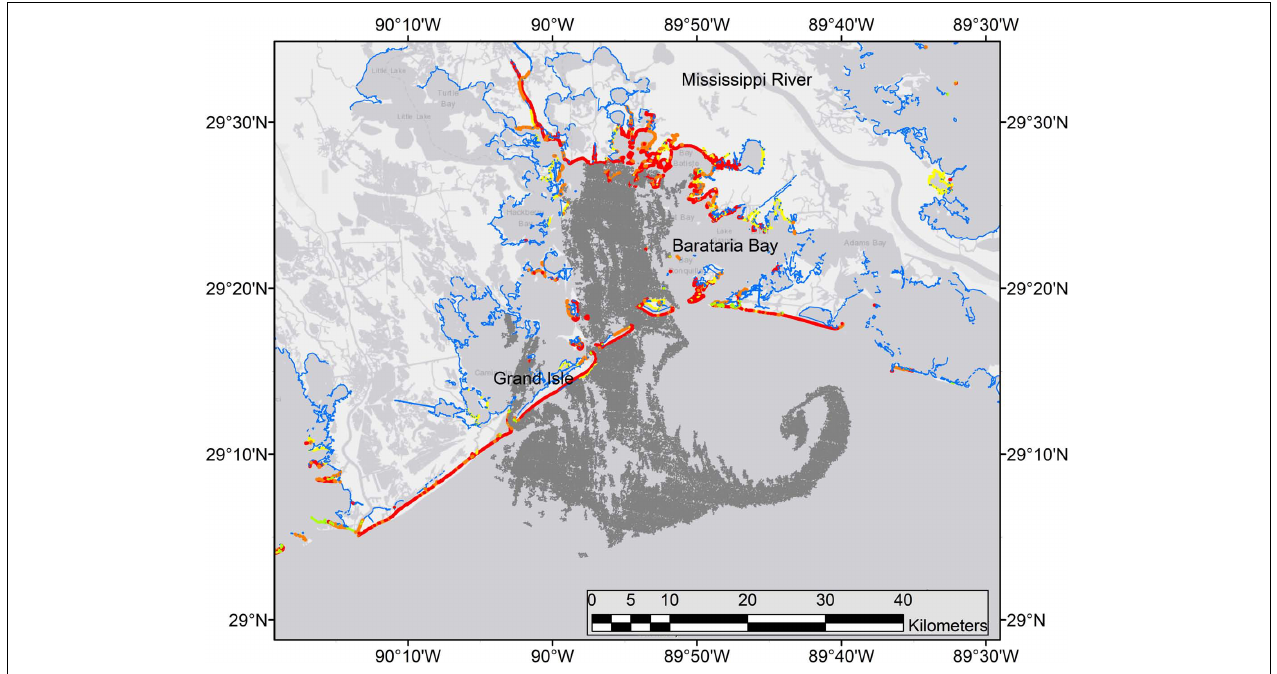
FIGURE 11 | Synthetic aperature radar (SAR) image of oil at the sea surface (dark gray) across the mouth of Barataria Bay, Louisiana, June 4, 2010. Details of instruments and processing methods are given here: https://erma.noaa.gov/admin/layer/32308. Colors represent shoreline oiling categories as in Figure 1 .